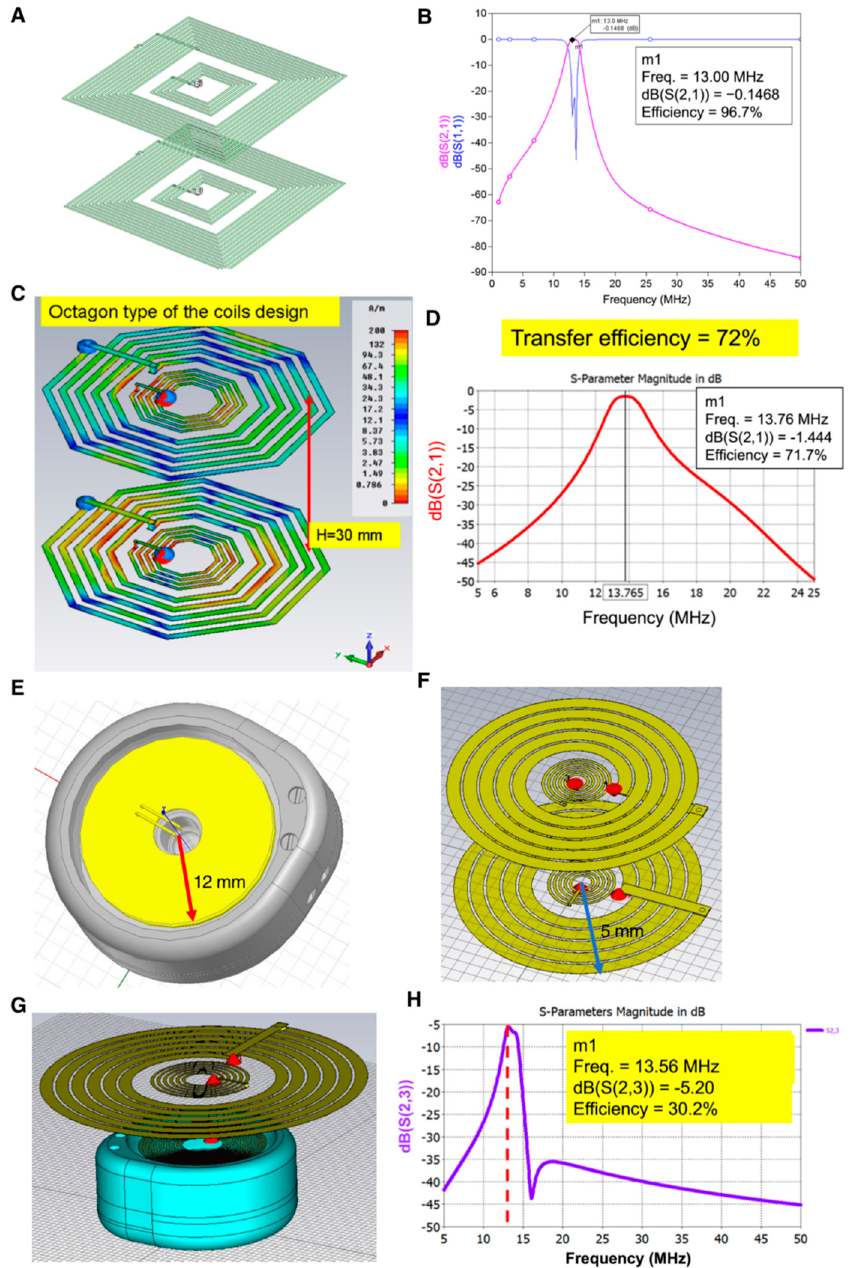
Figure 3. Resonant coupling architecture for wireless energy transmission. ( A ) Simulation model of resonant coupling in square cortex wires. ( B ) The transmission efficiency of resonant coupling in square cortex wires. ( C ) Design of round-shaped architecture with octahedral cortex wires. ( D ) The transmission efficiency of octahedral wires with resonant coupling technology. ( E ) Design of round-shaped titanium case for wireless energy transmission. ( F ) The Archimedes coils design in receiver. ( G ) Top to bottom view of round-shaped transmitter and receiver. ( H ) The transmission efficiency of the round-shaped circular wires with resonant coupling technology for wireless energy transmission.